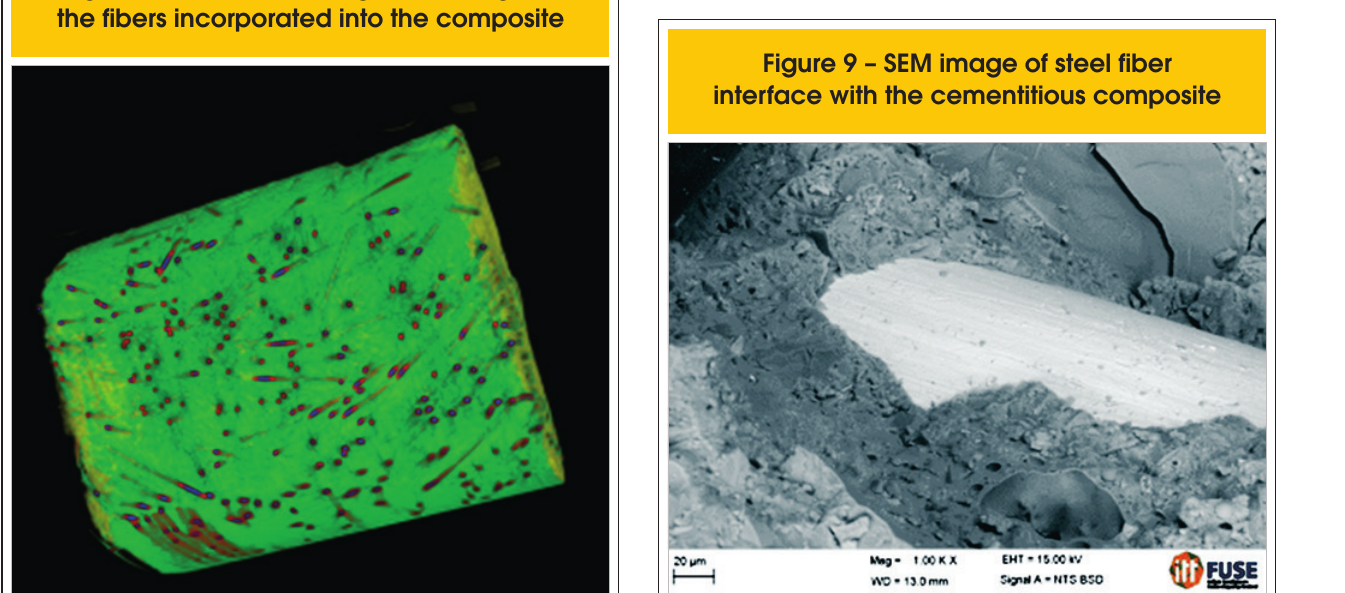
Figure 8 – 3D microtomography image of the fibers incorporated into the composite